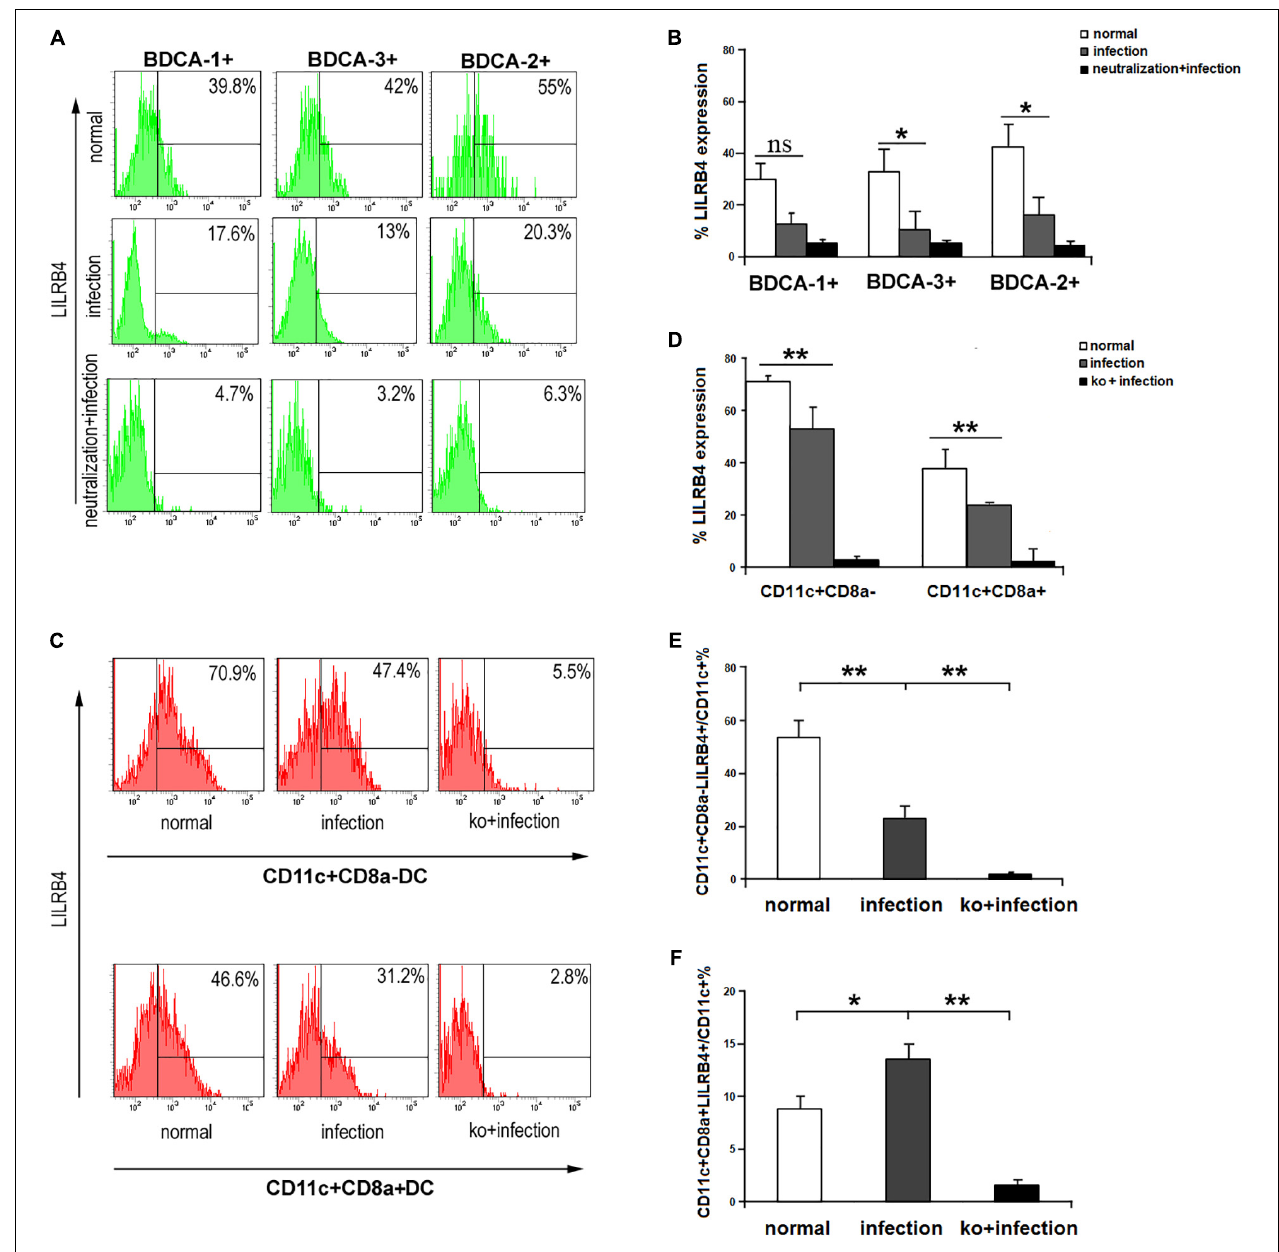
FIGURE 3 | Expression of LILRB4 on uDC subsets was down-regulated following T . gondii infection. (A) Flow cytometry analyses of LILRB4 expression on BDCA-1 + (BDCA-1), BDCA-2 + (BDCA-2), and BDCA-3 + (PDC) uDC subsets were performed in normal, infected, and LILRB4-neutralized infected human uDCs. (B) LILRB4 expression changes were compared after T . gondii infection in human BDCA-1 + , BDCA-2 + , and BDCA-3 + uDC subsets from normal, infected, and LILRB4-neutralized infected groups. (C) Flow cytometry analyses of LILRB4 expression in CD11c + CD8a + and CD11c + CD8a − uDC subsets were performed in normal, infected, and LILRB4 − / − infected mice. The changes of LILRB4 expression compared between CD11c + CD8a + and CD11c + CD8a − uDC subsets were showed as (D) CD11c + CD8a − LILRB4 + /CD11c + CD8a − % or CD11c + CD8a + LILRB4 + /CD11c + CD8a + %, (E) CD11c + CD8a − LILRB4 + /CD11c + %, (F) CD11c + CD8a + LILRB4 + /CD11c + %. Data are shown as means ± SD ( ∗ p < 0.05, ∗∗ p < 0.01). Representative data from 10 independent experiments for each